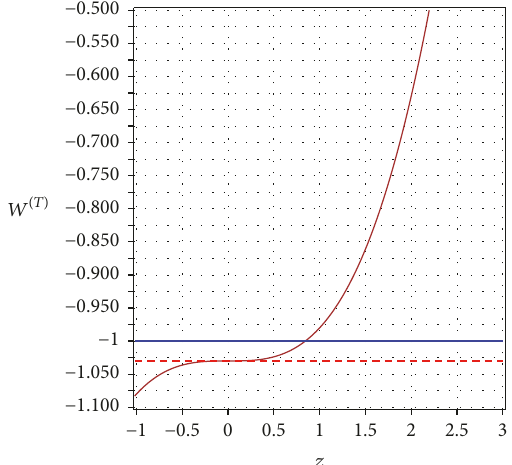
Figure 6: Variation of effective equation of state parameter versus the redshift for 𝑓(𝑇) = 𝑇 + 𝑛(𝑇 − 𝑇𝑒 (𝛽𝑇 0 /𝑇) + (−𝑇) 𝛽 ) , where the dash lines represent 𝜔 (𝑇) 0 = −1.03